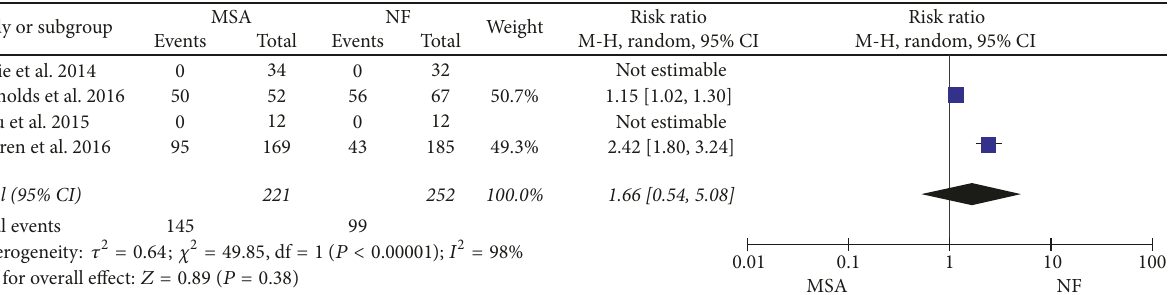
Figure 2: Forest plot of studies evaluating risk ratios of postoperation PPIs